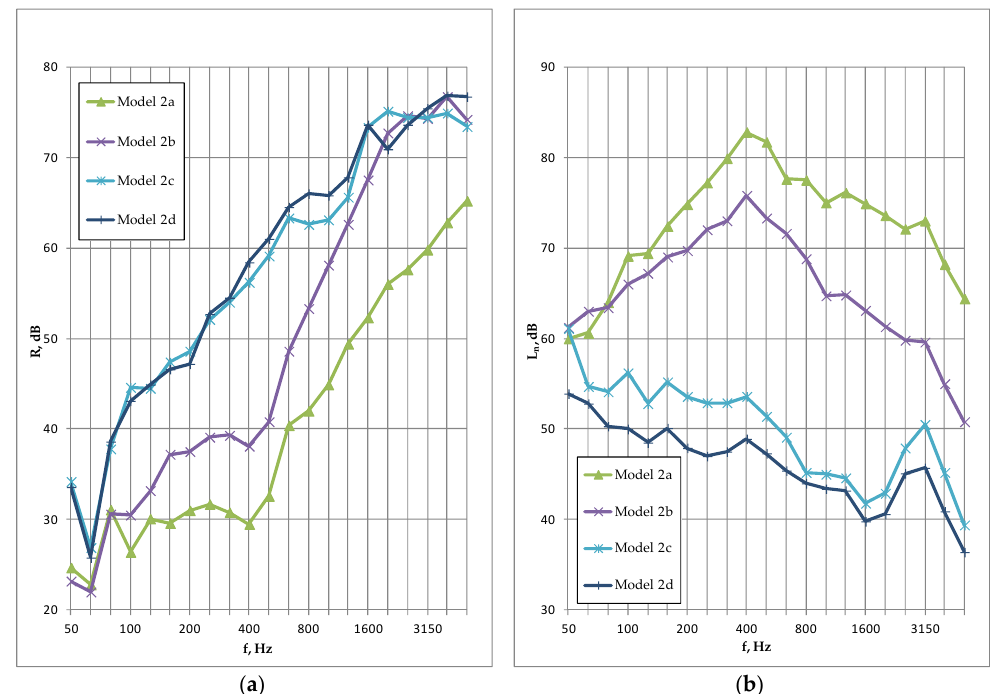
Figure 11. Airborne ( a ) and impact ( b ) sound insulation test results of a metal frame floor. The absorption inserted into the cavity on the bottom side of the floor, consisting of a 100 mm layer of glass wool, substantially improved the single-number values but they are still far from meeting even the lowest acoustic requirements (model 2b). The enhancement of sound insulation due to the absorbing material ranges from about 7 dB in the middle frequency bands to around 13 dB at high frequencies. The initial effect at 400 Hz may also be observed in the case of model 2b. The application of a suspended ceiling, which closed the floor structure on the bottom side (models 2c and 2d), changed the shape of the airborne sound insulation curves considerably. This is typical of a double lightweight frame structure with a boarding fastened on both sides to different, structurally separated parts of the frame. Airborne sound insulation improved mainly in the low and middle frequency bands, whereas impact sound insulation increased in a significantly wider range, also including high frequencies. The decrease observed at 400 Hz in the case of models 2a and 2b essentially disappeared; however, it is still slightly evident in the impact sound insulation plots (Figure 11b). In the case of models 2c and 2d, a distinctive increase of impact sound pressure level also appeared at 3150 Hz. This is related to the coincidence effect of the plasterboard panels [32–34]. Model 2d was constructed by screwing the second layer of plasterboard to the single ceiling used in model 2c. In consequence, airborne sound insulation slightly improved, and the normalized impact sound pressure level L n,w decreased by 4 dB, which makes its value acceptable in residential buildings. The values of C I and C I,50-3150 spectrum adaptation terms are negative for all variants of model 2. These mean better acoustic performance in the low frequency range than that observed in the case of the wooden floors, where the values were positive in each case. The airborne spectrum adaptation terms C and C I,50–3150 are also advantageous in comparison with wooden floors. This behavior of metal structures, in acoustic terms, is more similar to that of massive floors than lightweight frame partitions. The single-number quantities obtained for models 2c and 2d are promising (Table 6).